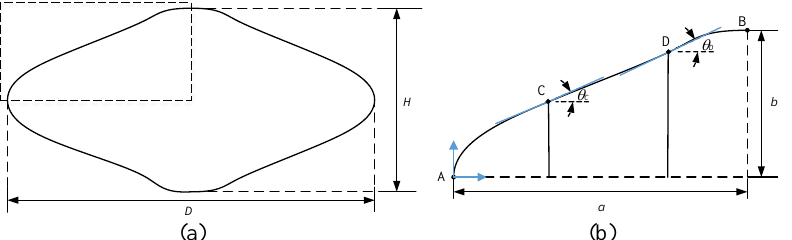
Figure 3. The sketch of AUH’s NURBS profile and its parametric description: ( a ) the overall outline, ( b ) a quarter profile with parametric